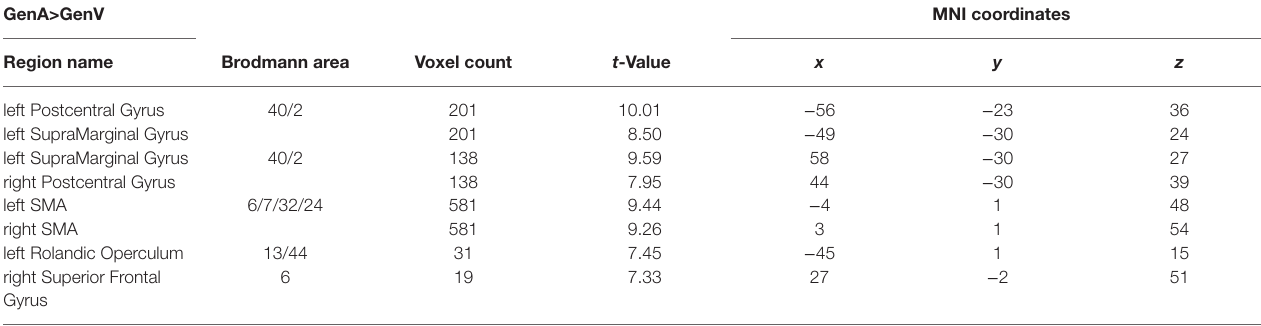
TABLE 3 | Activation peaks and extents for